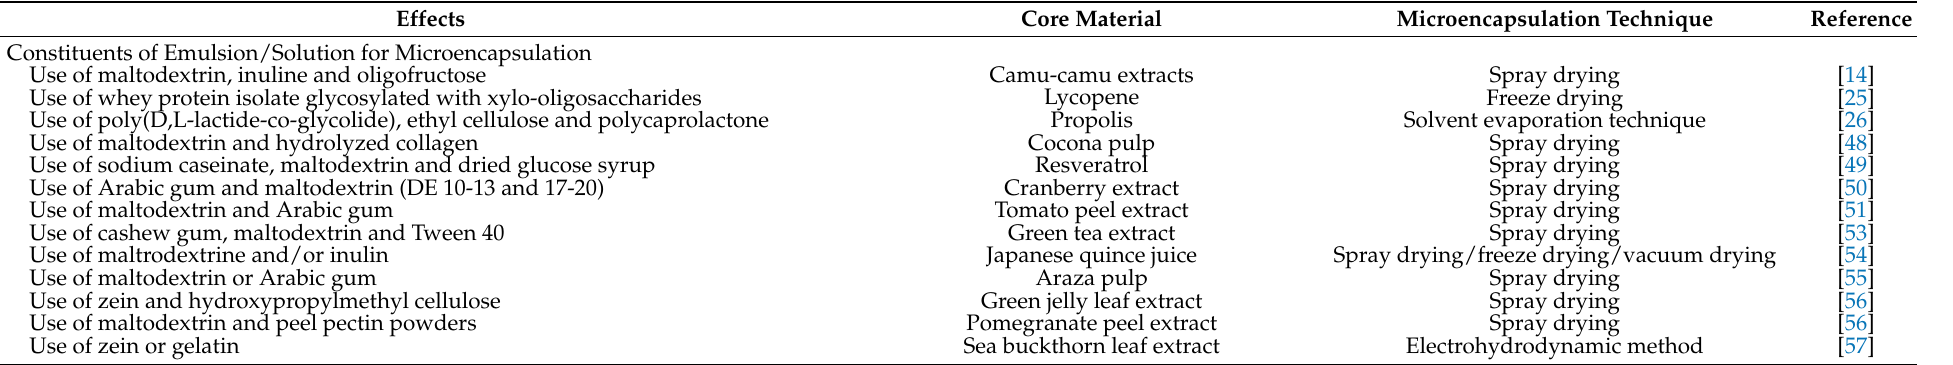
Table 2. Evaluated effect, related to the solution constituents, the procedure and the food enrichment, in recent studies for the development of natural antioxidant